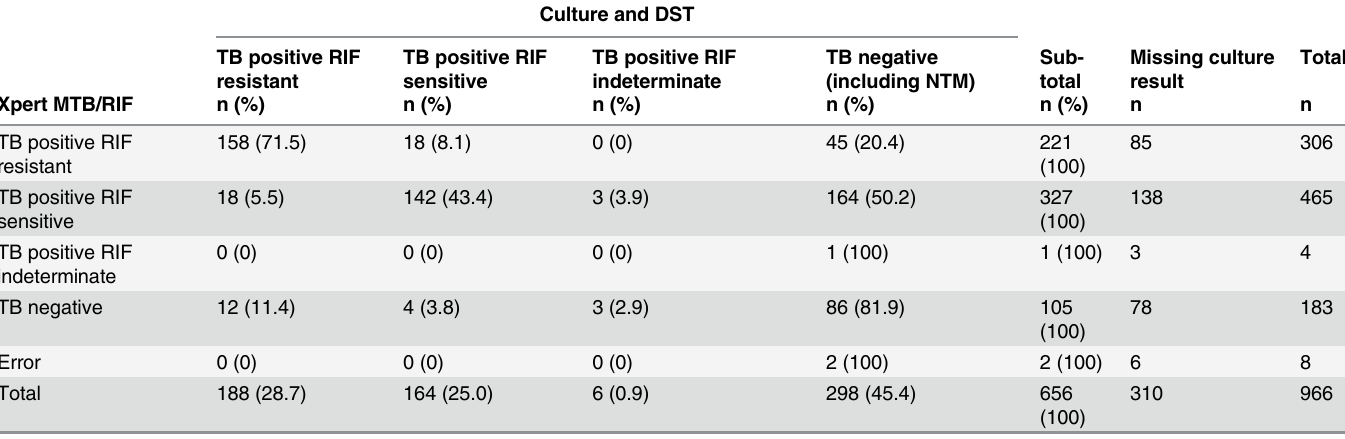
Table 3. Culture and drug-susceptibility testing results following Xpert MTB/RIF testing within the same individuals at risk of multidrug-resistant TB in three provincial hospitals in Java, Indonesia. Culture and